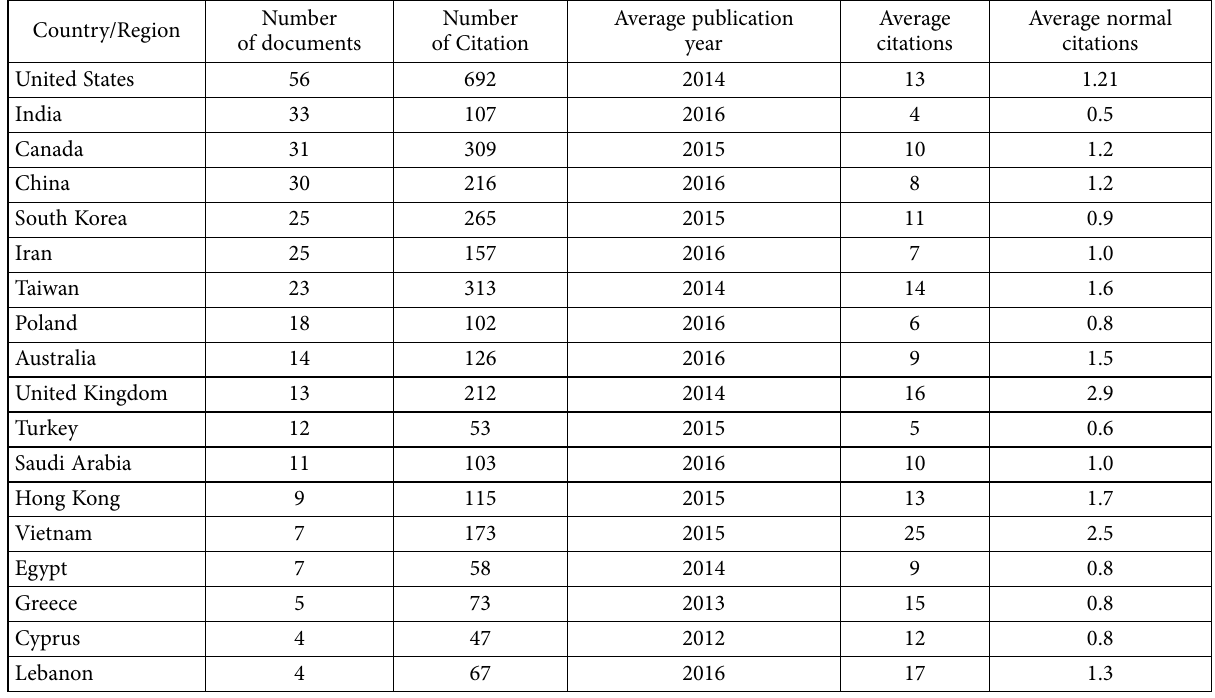
Table 6. Summary of most influential countries/regions in CPS